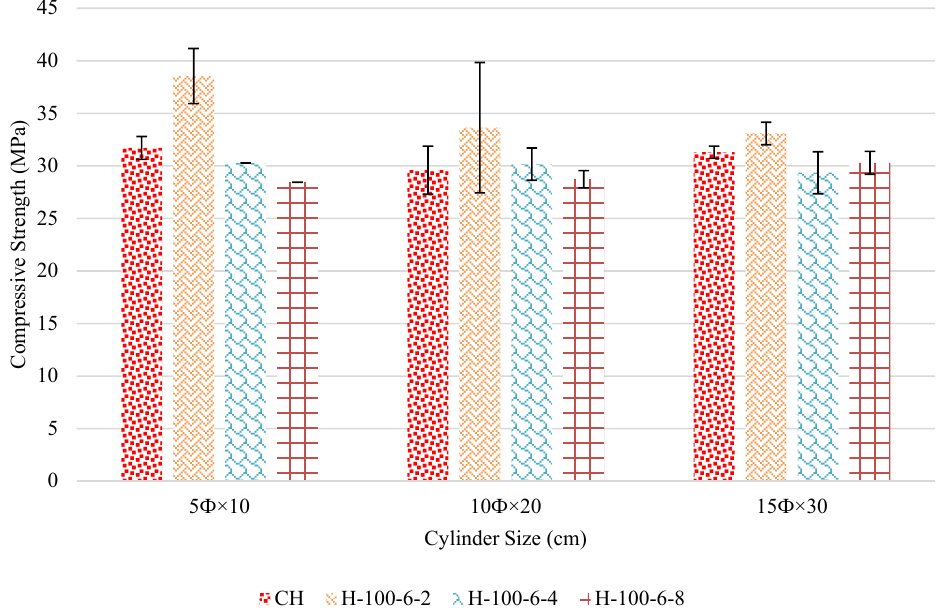
Figure 4. Result of 3-day high strength concrete of different size cylinders cured with 100% CO 2 .